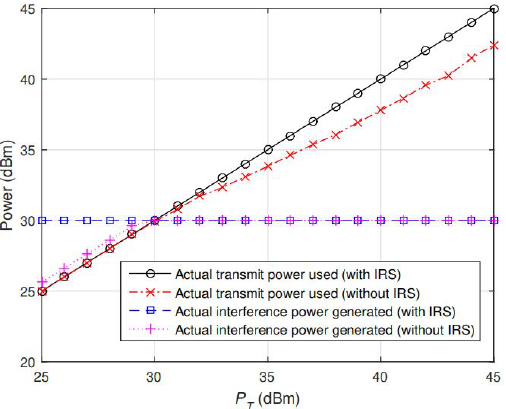
Figure 3. The actual transmit power used at Alice and actual interference power generated to PR under IRS-assisted and no-IRS case under same settings as in Figure 2. Note that tr ( R ) = P T always holds under IRS-assisted case, i.e., total power constraint (TPC) is always active even when IPC is